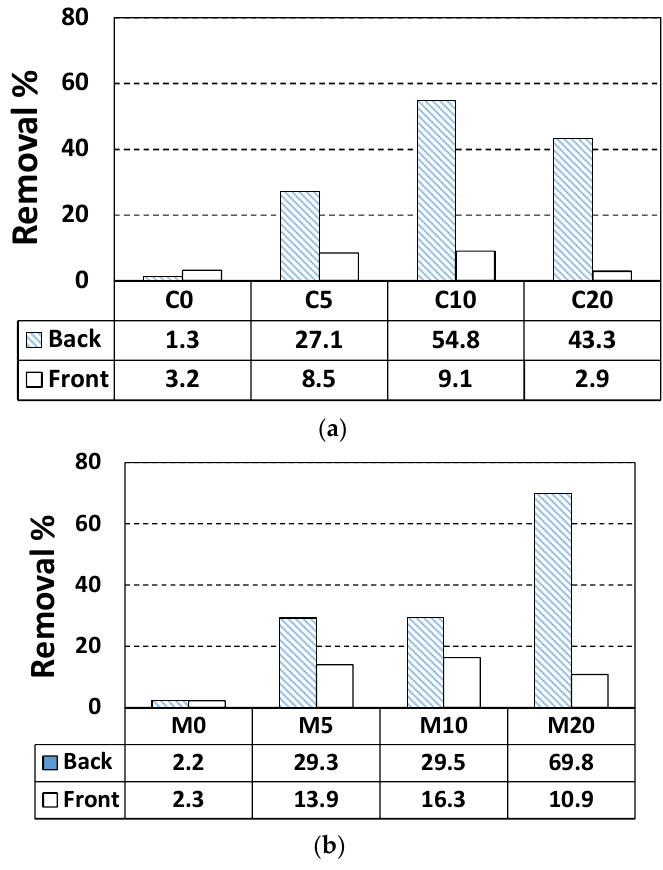
Figure 8. NO removal by cement paste and mortar: ( a ) cement paste; ( b ) mortar with NP-400.